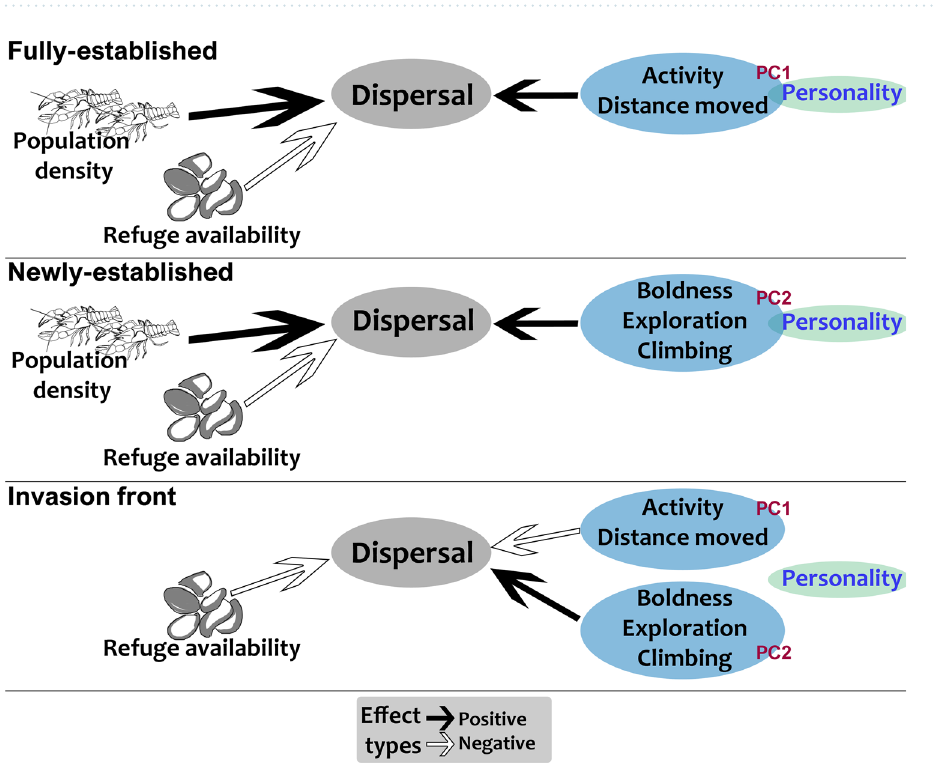
Figure 4. Conceptual diagram showing impacts of personality traits, population density and refuge availability on dispersal of wild signal crayfish at sites differing in terms of invasion